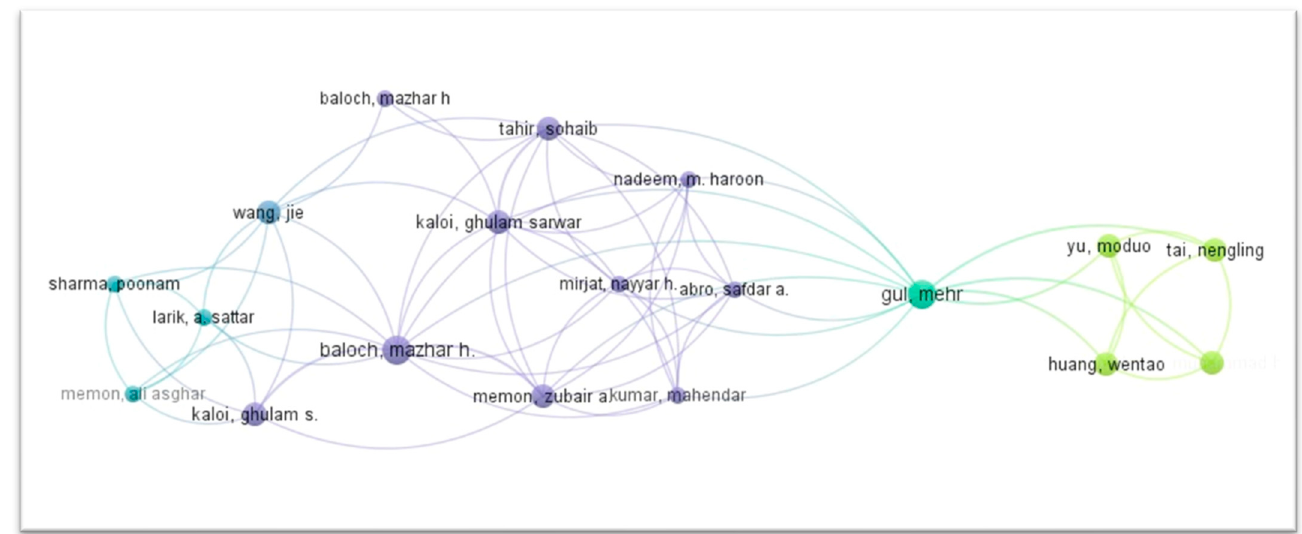
Figure 9. Co-citation network by authors.